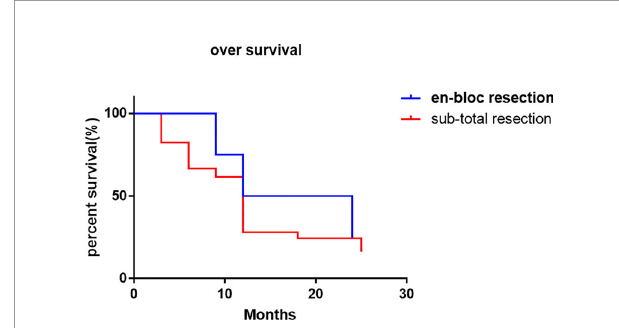
FIGURE 3 | ECOG score compared the scores of the patients pre, 1 month post and 3 months post operation. ****P < 0.0001 and indicated the ECOG scores decreased after surgery.